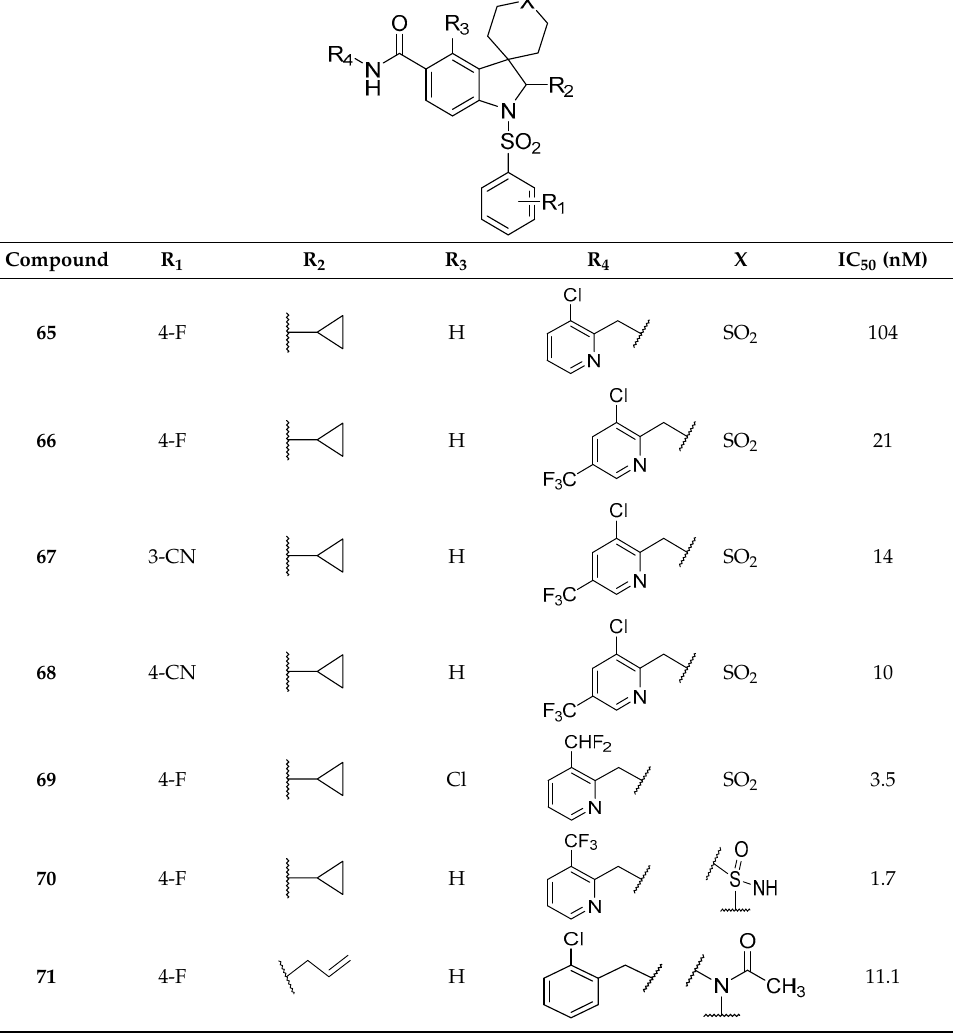
Table 13. Other GnRH antagonist